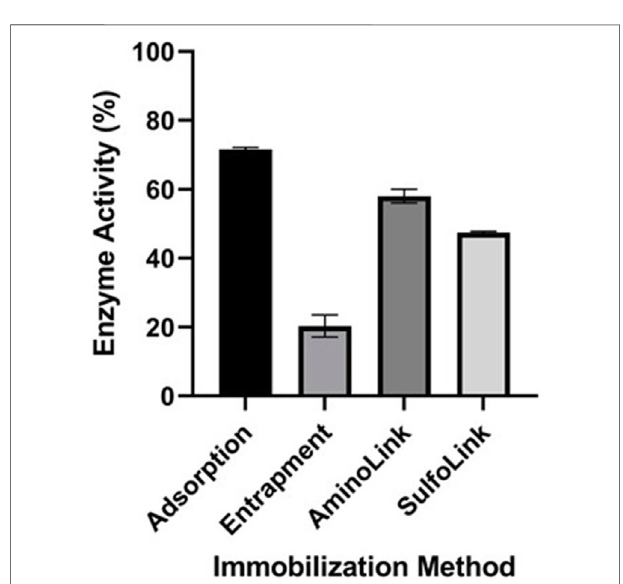
FIGURE 4 | Enzyme activity of immobilized EndoBI-1 (adsorption, entrapment,AminoLink,andSulfoLink)onLPO.Errorbarsrepresentstandard deviation and mean values of different groups and are signi fi cantly different at p < 0.05.